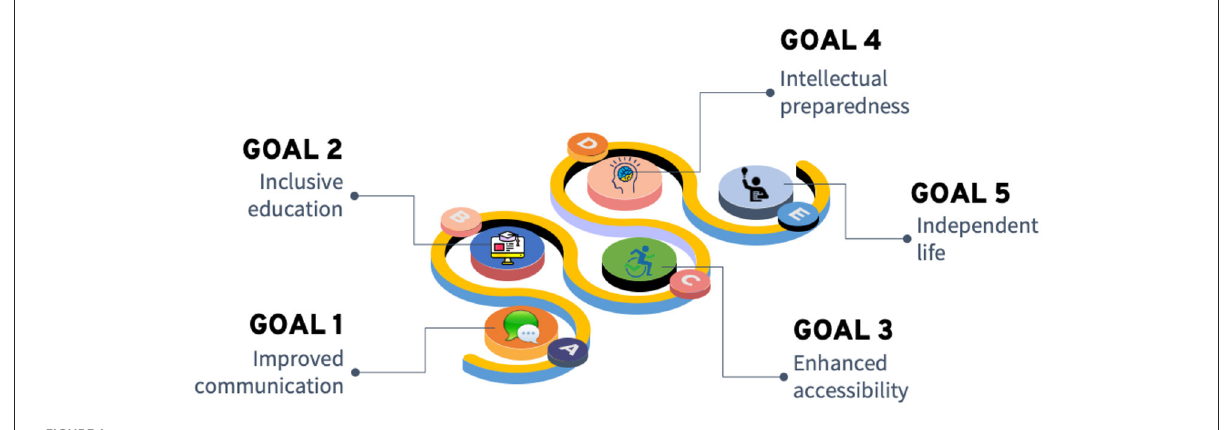
FIGURE1 AI enabled goals to support children with